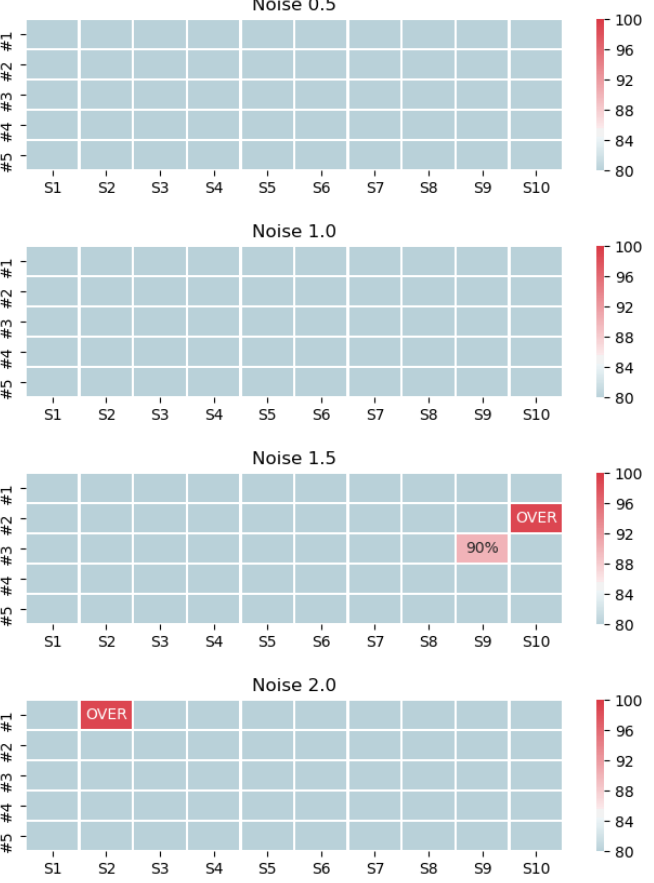
Figure 7. Random value: What prediction range the actual value belongs